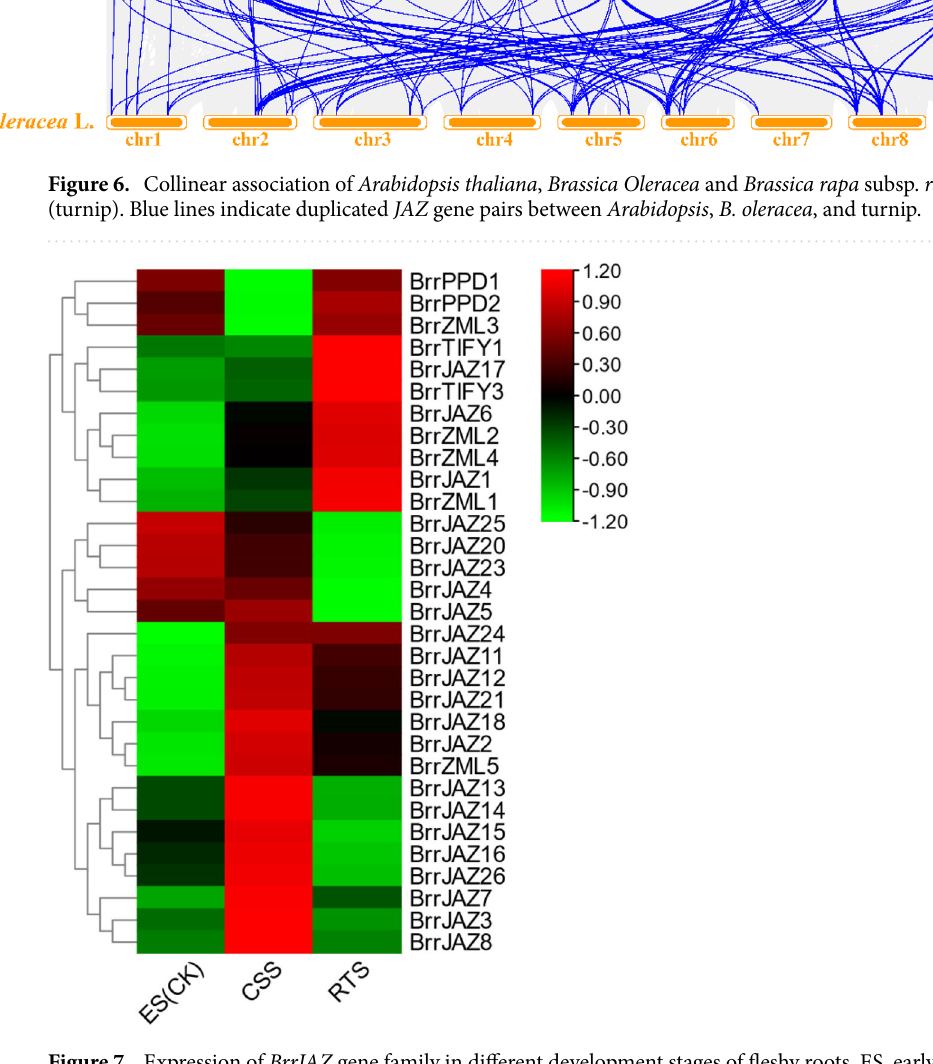
Figure 7. Expression of BrrJAZ gene family in different development stages of fleshy roots. ES, early stage before cortex splitting. CSS, cortex splitting stage. RTS, secondary root thickening stage. FPKM values of BrrJAZ genes were transformed by log2 and the heatmap was constructed by